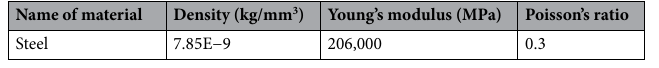
Table 3. Material parameters 24 .